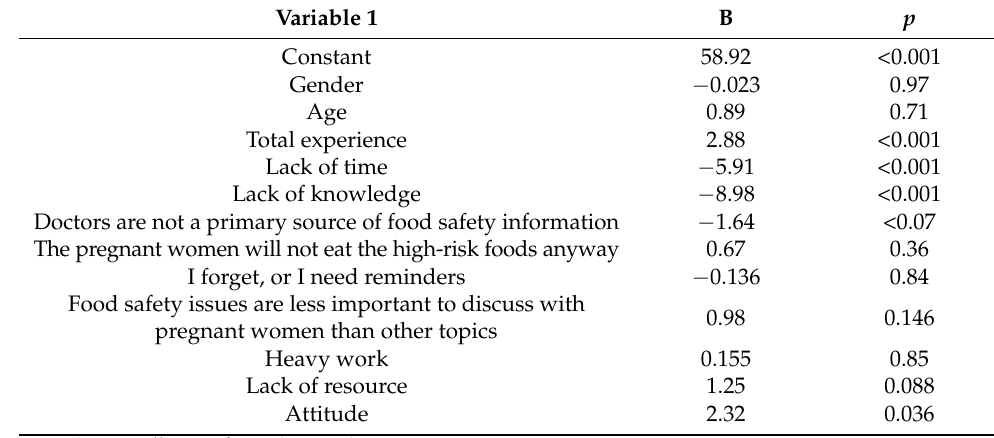
Table 5. Factors influencing food safety education practices. Variable 1 B p Constant